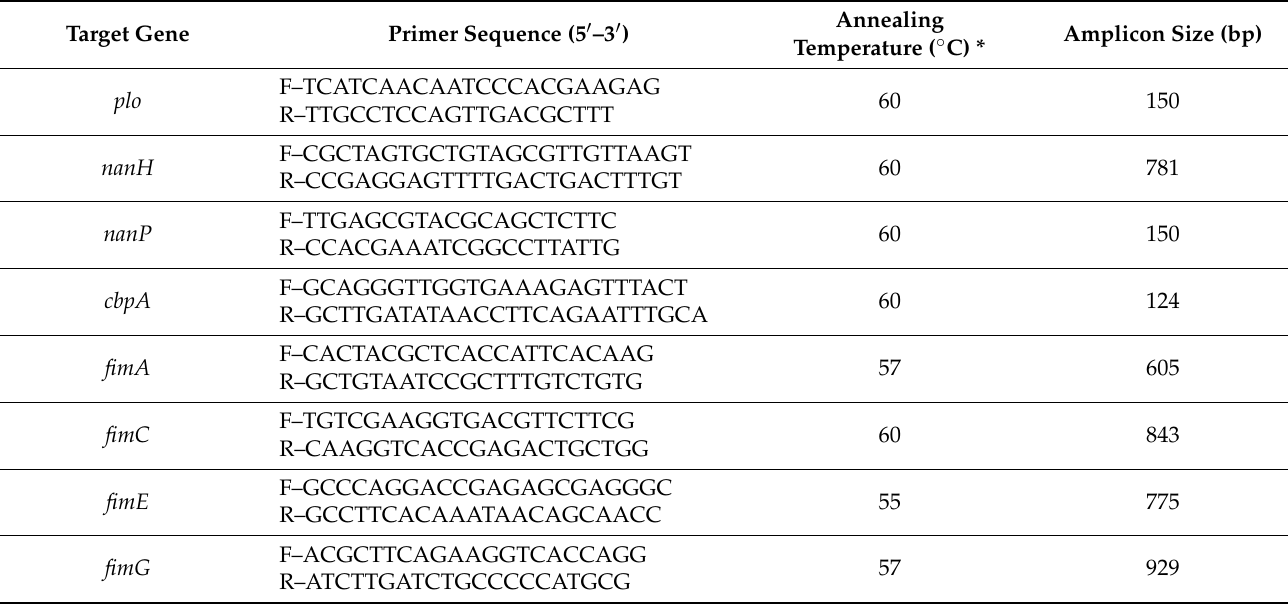
Table 1. The primer sets and reaction conditions used in this study for PCR detection of virulence genes